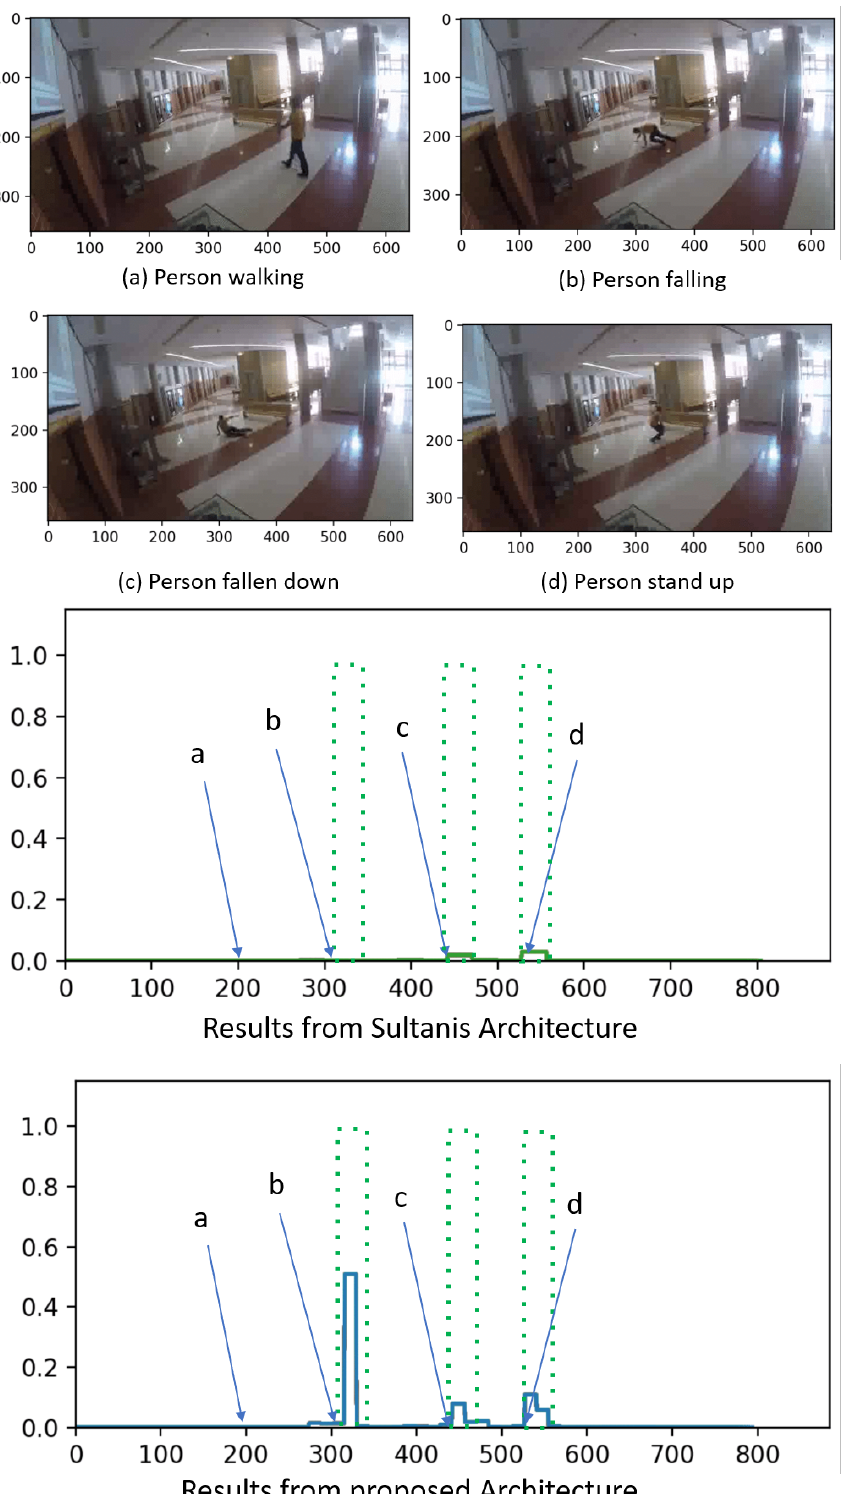
Figure 2. Qualitative visual results and comparison in scenes from GBA. The proposal in this work is also tested on the dataset of normal and crowd scenes called The Web [37]. It contains high quality crowd and normal videos in different scenes which are collected from sites such as Getty Images and ThoughtEquity.com. This